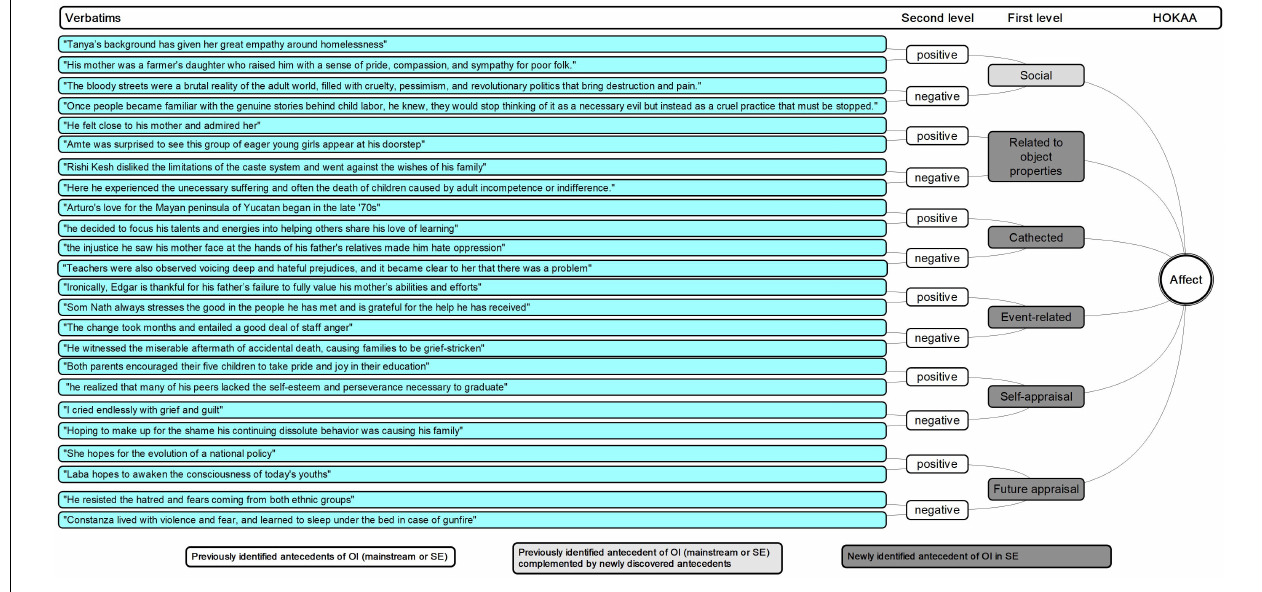
FIGURE 5 | HOKAA ‘Affect’: emerging antecedents.